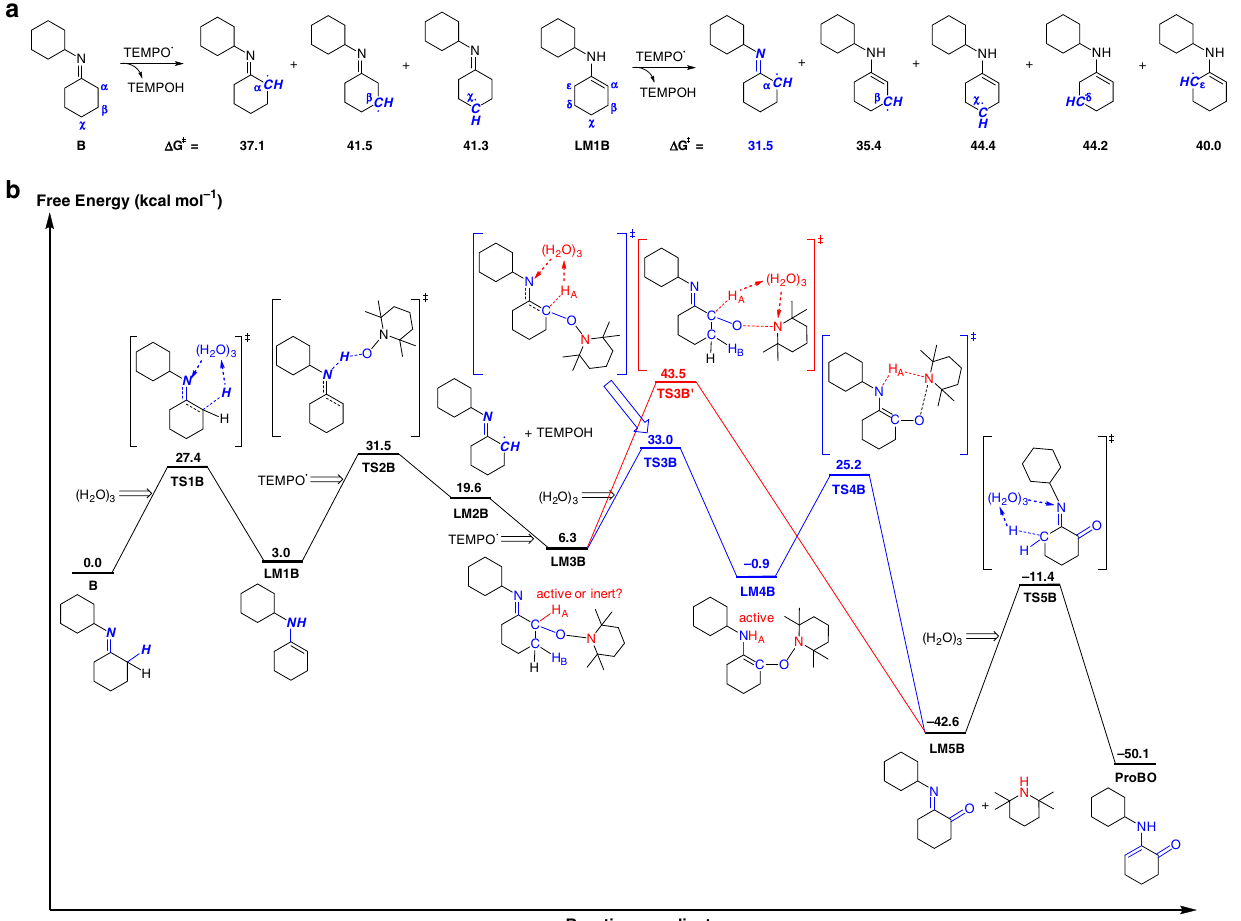
Fig. 7 Computational investigation on the mechanism for oxidation of imine by TEMPO. Numbers are Gibbs free energies (kcal mol -1 ) with respect to the imine reagent B and TEMPO. a Activation free energies of the hydrogen abstraction of imine molecule B and its tautomer LM1B by TEMPO in different reactive sites. b Free energy pro fi les for oxidation of imine molecule B by TEMPO. The pathway for the elimination of H A /piperdine via imine-enamine tautomerization is shown in blue line and the pathway for the direct elimination of H A /piperdine is shown in red